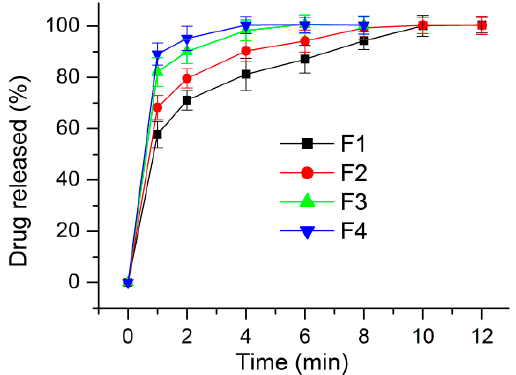
Figure 11. In vitro dissolution experimental results.